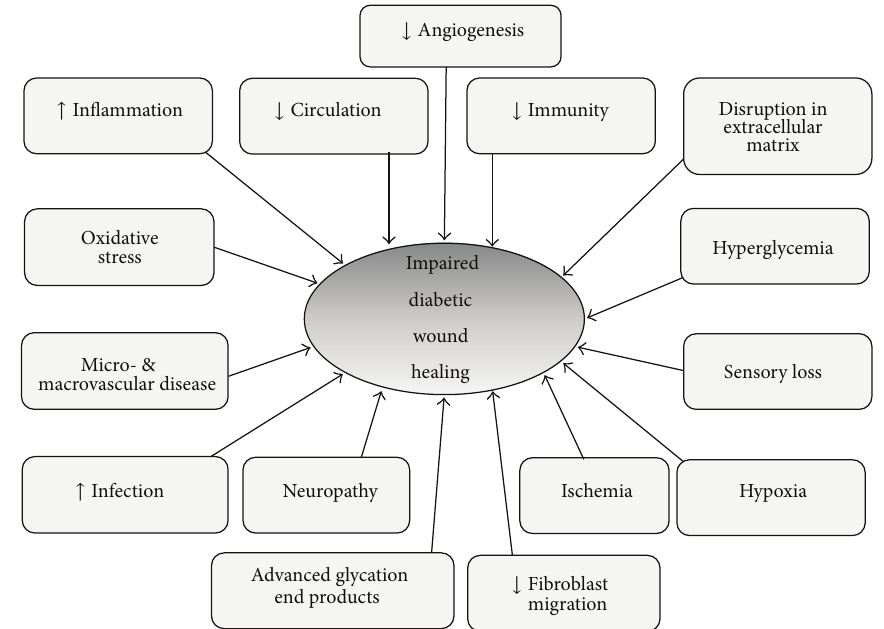
Figure 1: Some of the underlying pathogenesis of impaired diabetic wound